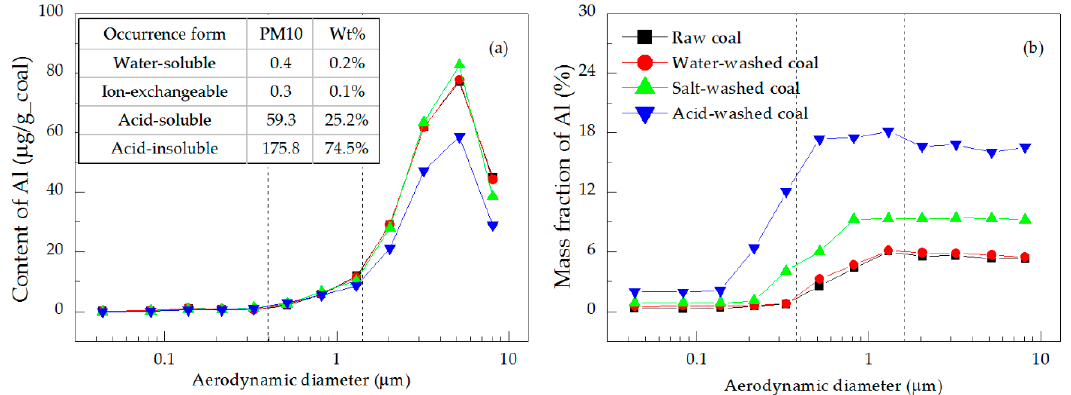
Figure 10. Distributions of the ( a ) content and ( b ) mass fraction of Al in the PM.